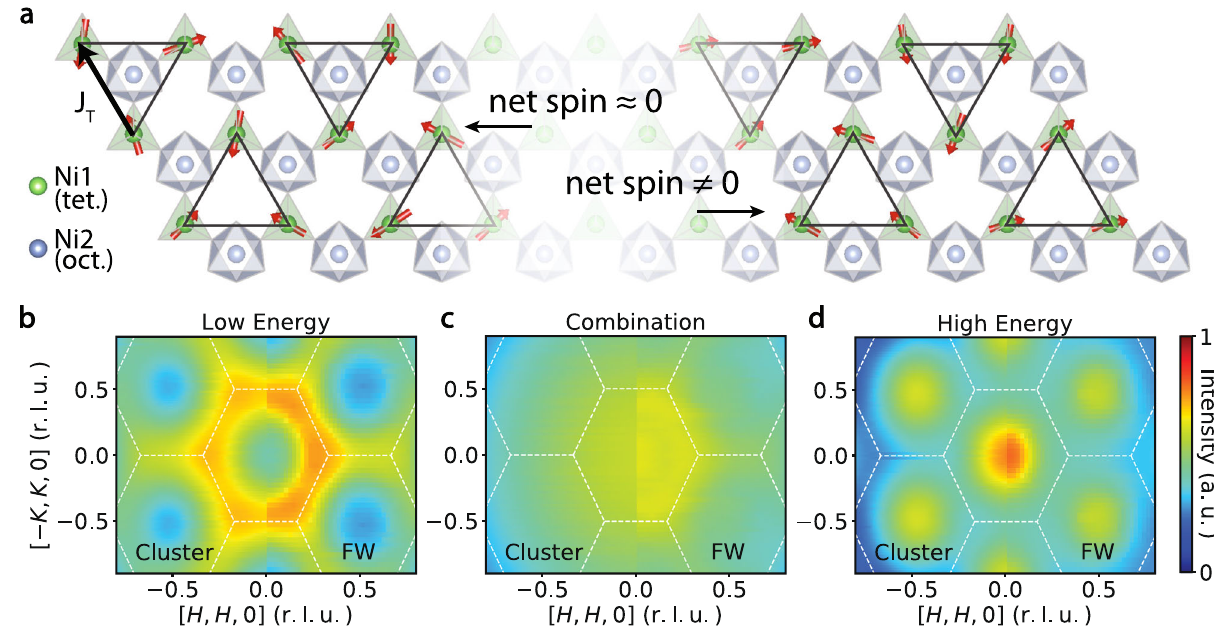
Fig. 4 | Structuralfactorsin Ni 2 Mo 3 O 8 calculatedonspin clustersandby fl avor wave (FW) method. a Schematic of spin clusters used to calculate the structural factors. The 120° con fi gurations with approximately zero net spin give rise to the pattern in which high intensity is near the zone boundary. The FM clusters lead to